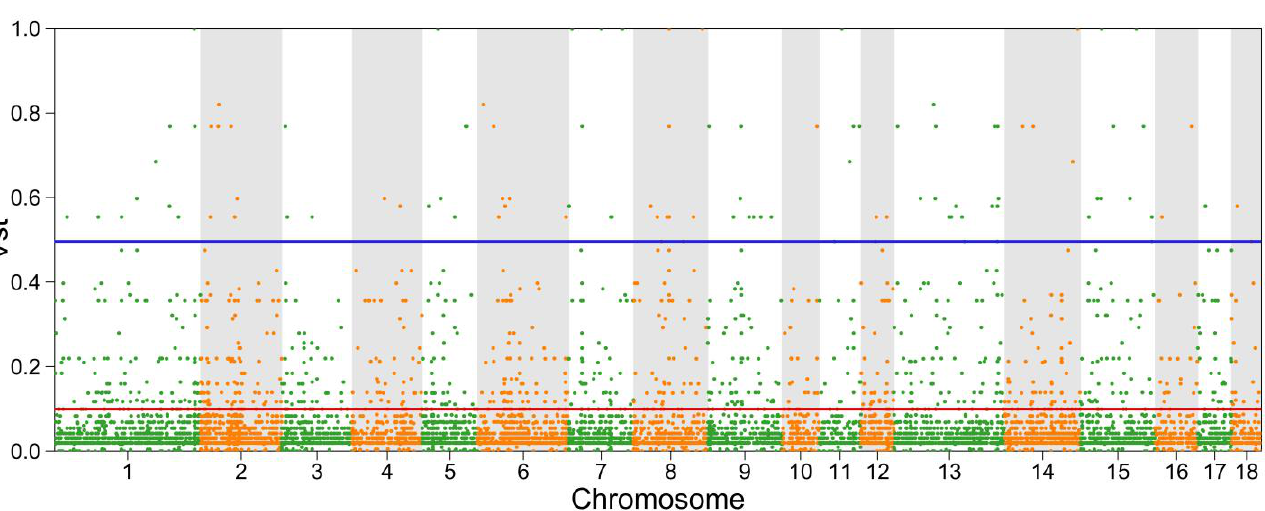
Figure 3. Evolutionary tree constructed from copy number variation regions (CNVRs); pink stripes and light blue stripes represent the AQ and SS groups, respectively.